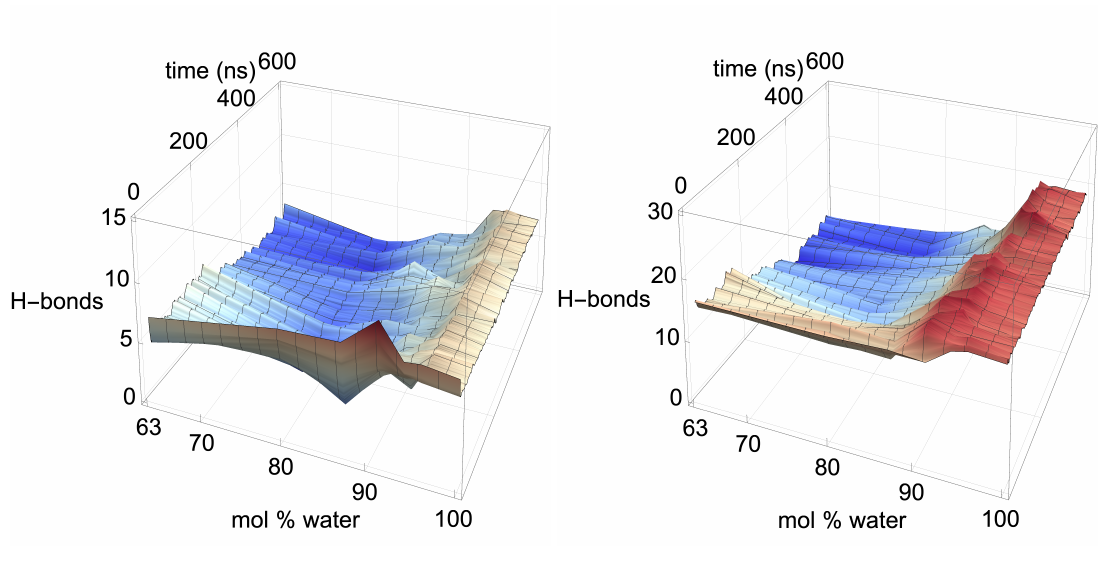
Figure 13. The hydrogen bonding for the first yellow separating strand at 360K (Part 2 of 2). The hydrogen bonds are shown between the following: ( a ) cellulose: intra–peeling strand (i.e., the intra-strand hydrogen bonds for the separating strand); ( b ) cellulose: inter–peeling strand (i.e., the inter-strand hydrogen bonds for the separating strand). These data represent the first yellow strand to peel or the non-peeling yellow strand if no yellow strands peeled in the simulation. The data were averaged over 1000 data points, using a rolling average. Every 100th point was then plotted to maintain plot clarity